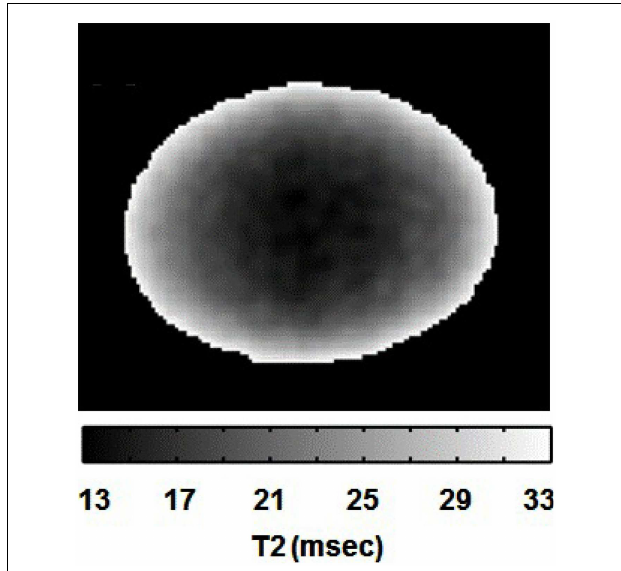
FIGURE 3 | T 2 gray-scale image of the bovine lens. The lightest area has the longest T 2 values and the darkest area has the shortest T 2 values.